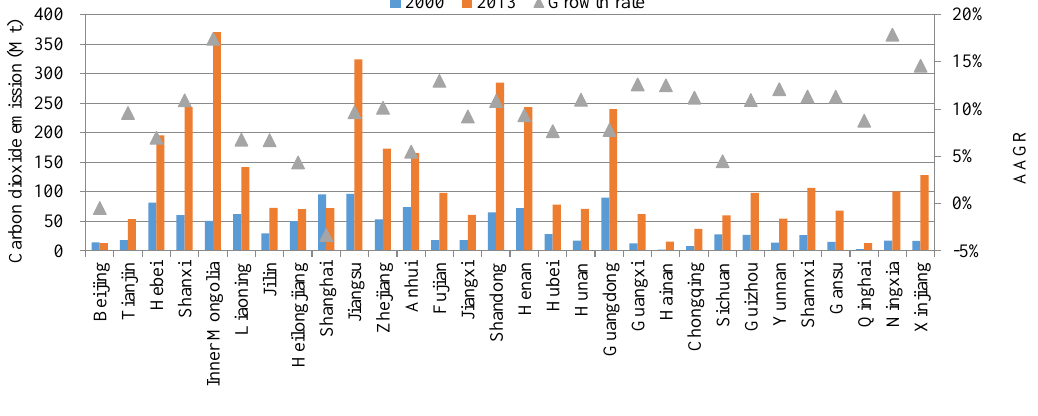
Figure 4. CO 2 emissions from thermal electricity generation and the related AAGRs of the 30 provincial power grids in China (2000 and 2013). Table 4. The mean energy consumption for provincial thermal electricity generation, 2000–2013. Mean Energy